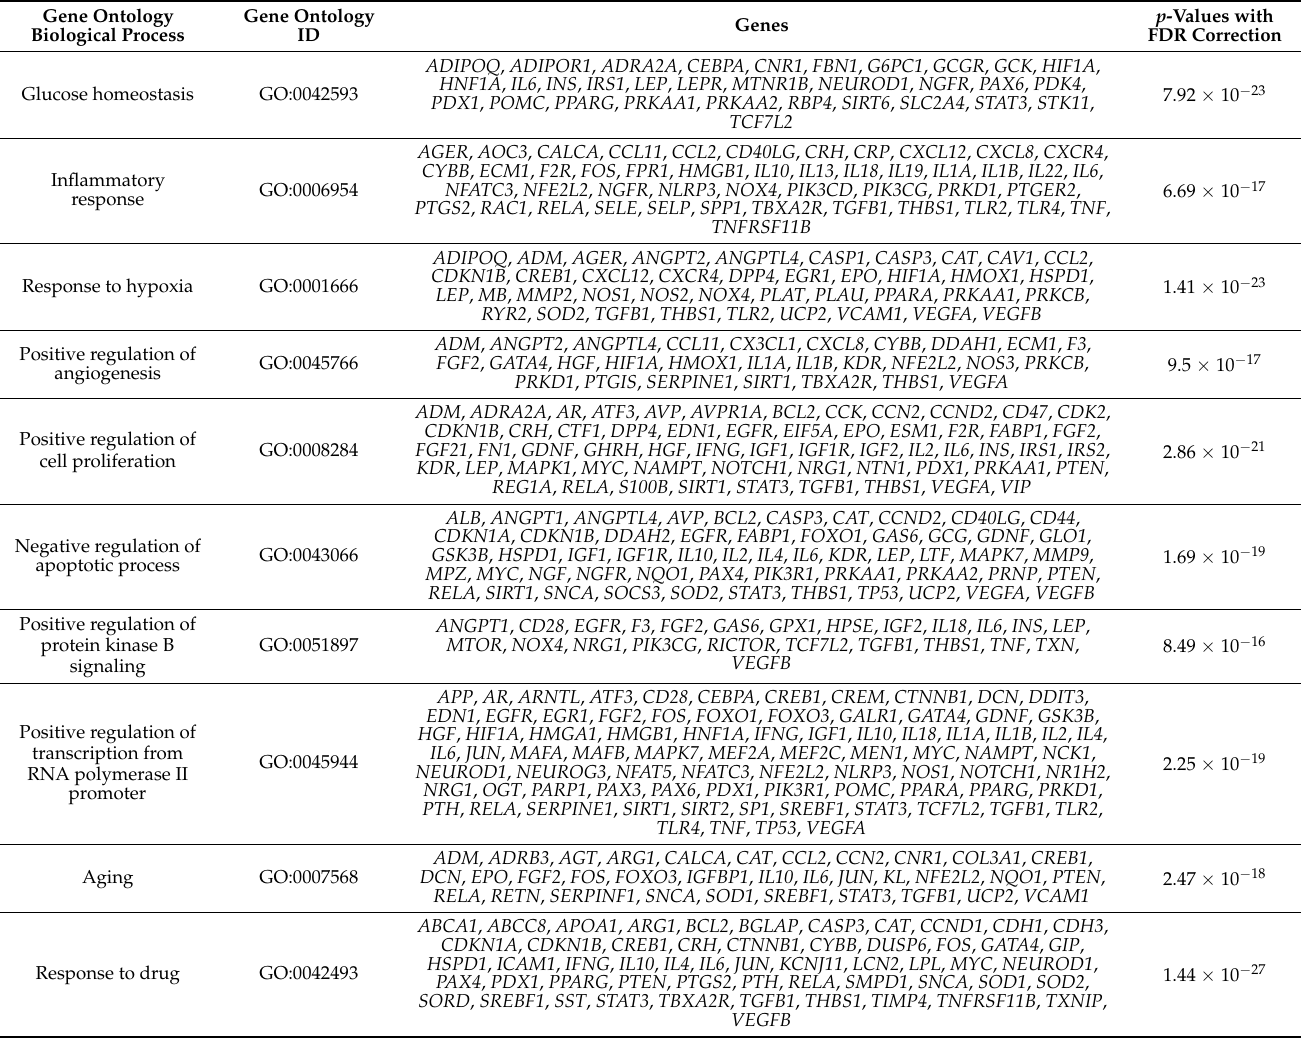
Table 1. Top 10 GO biological processes overrepresented for hyperglycemia-associated genes found by DAVID ( p -values with FDR correction <